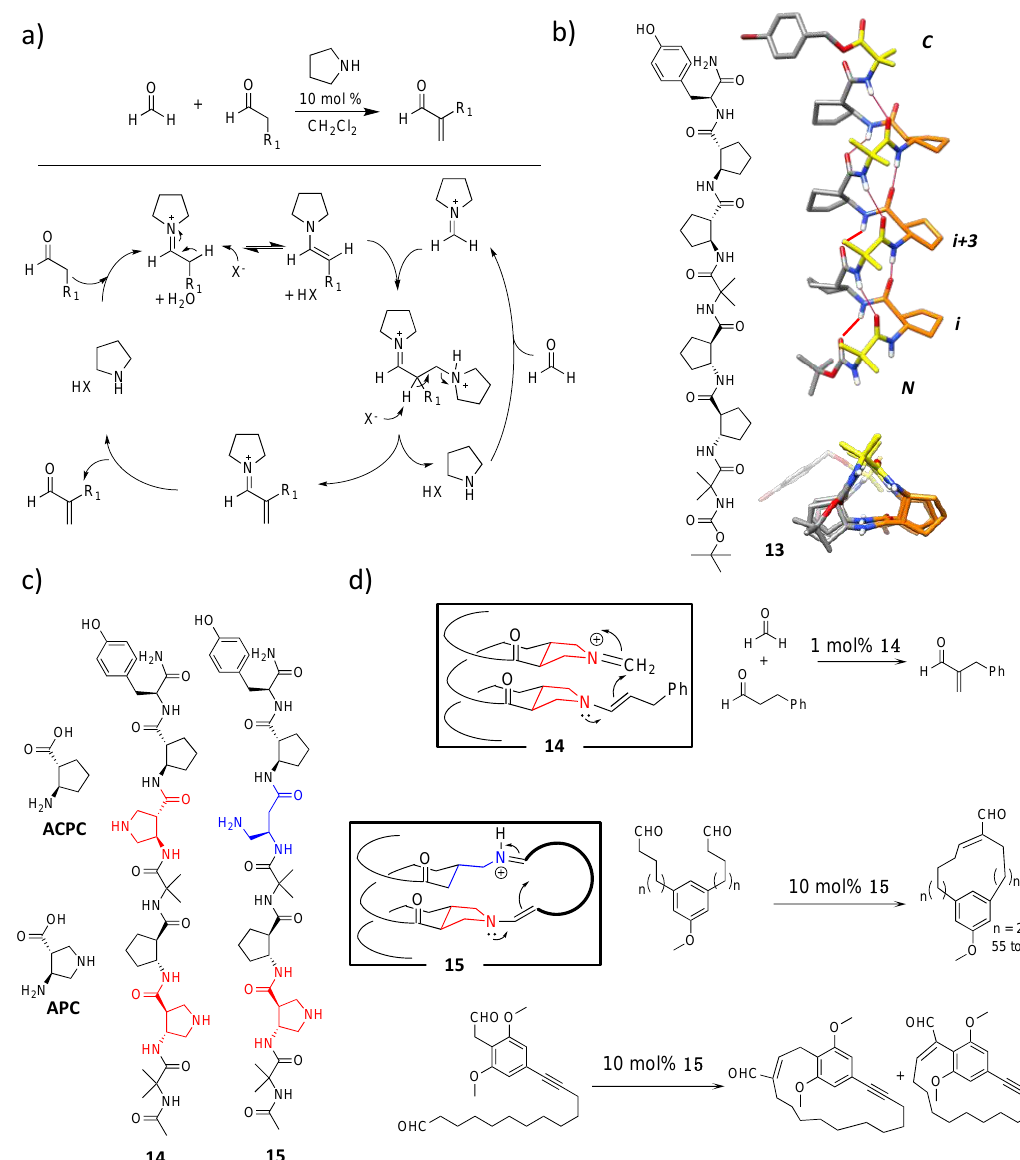
Figure 3. ( a ) Mechanism of the pyrrolidine-catalyzed α -methylenation of aldehydes [65]. ( b,c ) α / β / β -peptide bifunctional catalysts 14 and 15 were designed based on the helical secondary structures adopted by the ACPC-containing foldamer 13 (CSD: PUCDEX). ( d ) Foldamer-catalyzed α -methylenation and macrocyclization (reaction conditions: 2 equiv. triethylamine, 2 equiv. propionic acid, 4 vol % water, i -PrOH, 37 °C.